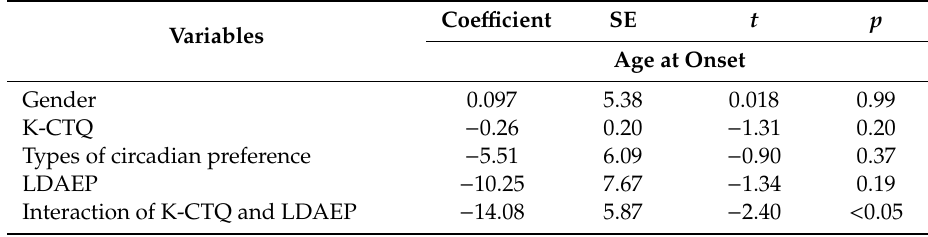
Table 4. Results of multiple linear regression analysis for the association between age at onset and clinical